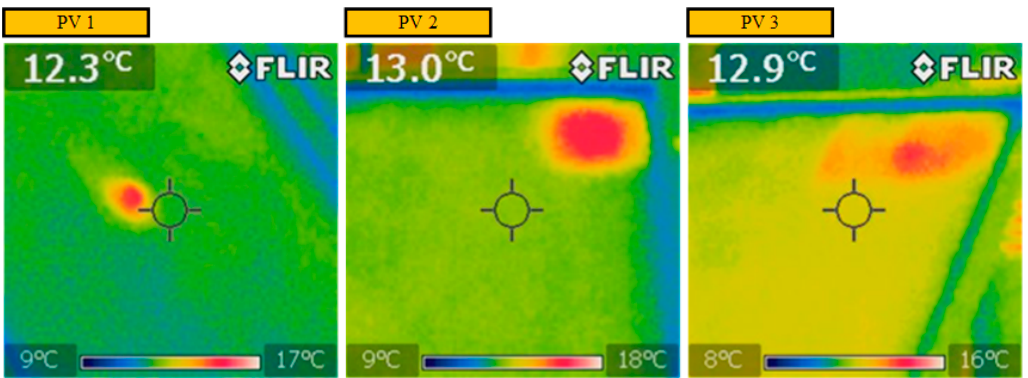
Figure 4. Hot spots captured in three different PV modules in the PV site C (Aberdeen PV site).